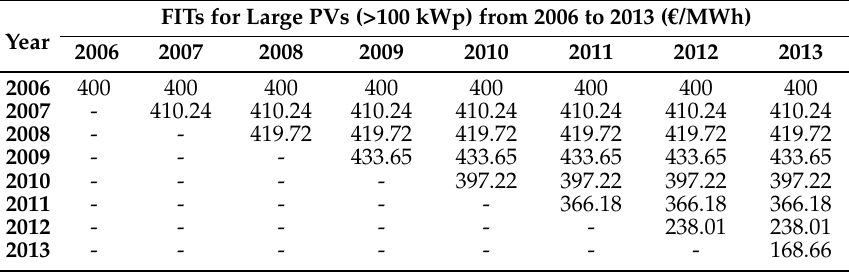
Table 3. FITs for large PVs (>100 kWp) from 2006 to